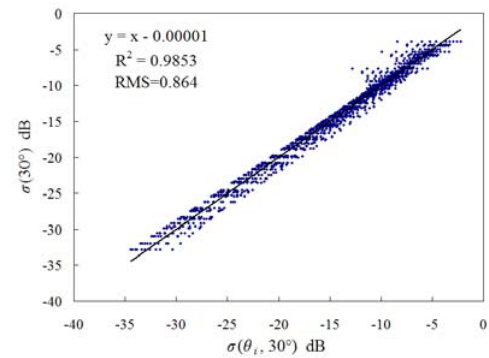
Figure. 2 Comparison of normalized backscattering coefficient σ ( θ i ， 30°) and σ (30°) simulated by AIEM